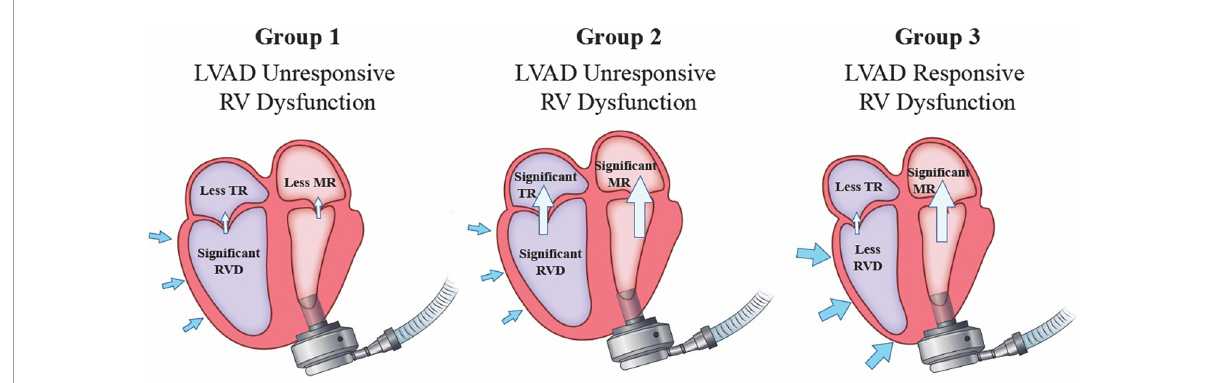
FIGURE1 Post-LVAD implantation echocardiographic findings on atrioventricular valve competency and underlying right heart function determines the risk of postoperative right ventricular failure.